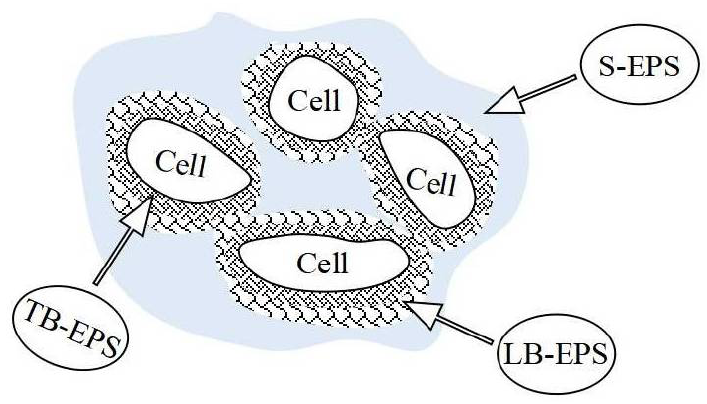
Figure 2. Schematic structure of EPS composition.